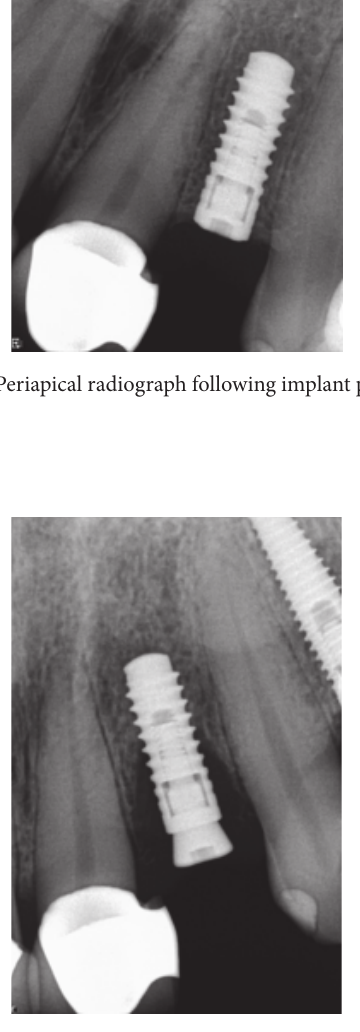
Figure7:Followingahealingphaseofabout3months,verticalbone loss around the implant was noted.